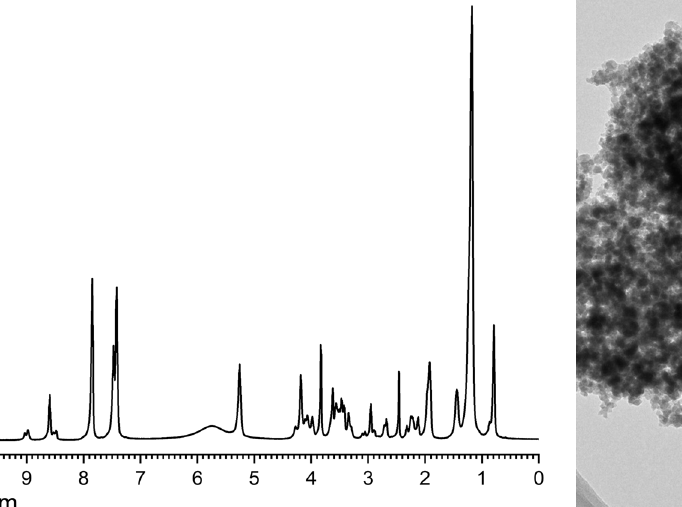
Figure 4: TEM micrograph of ROHA/SNP